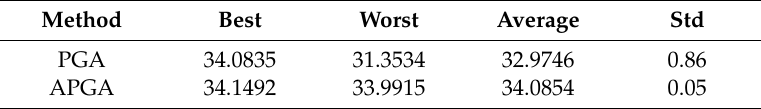
Table 12. Comparison of di ff erent methods for solving TDTPRP (60 attractions) Method